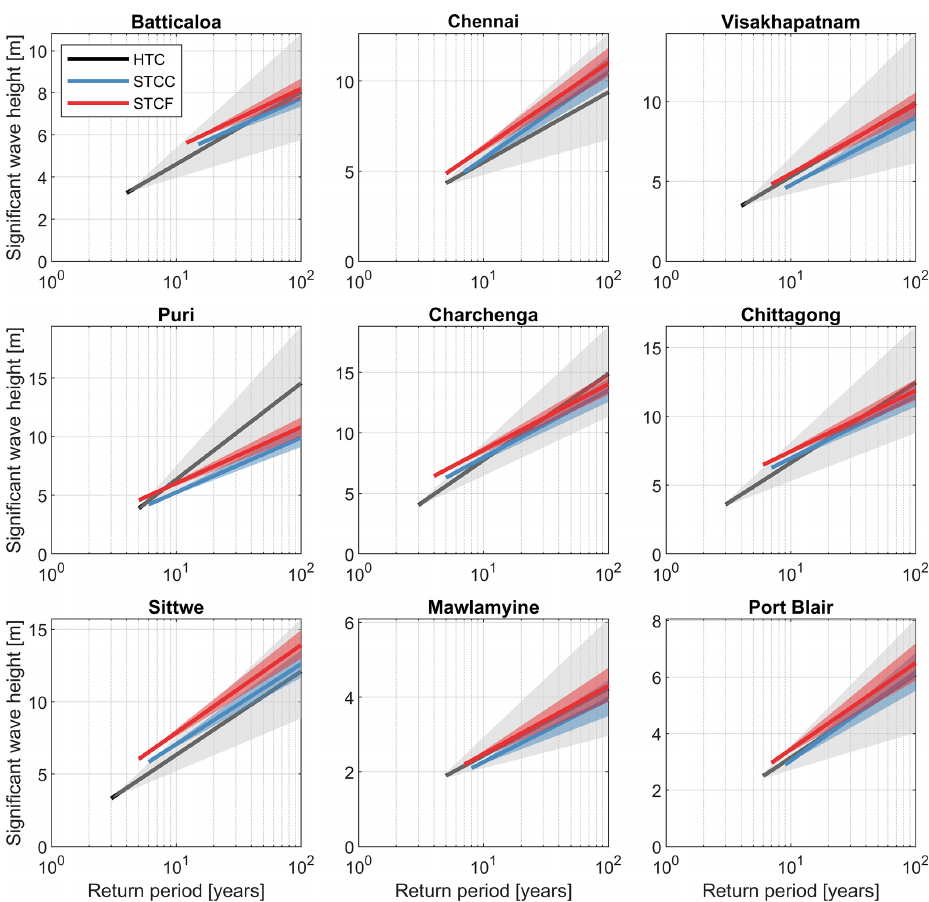
Figure 11. Extreme value analysis for nine different locations for significant wave height based on HTCs (black), STCC (blue) and STCF (red). Per panel both the fit (solid line) and 95% confidence intervals (background fill) are included. The horizontal axis is the return period on a logarithmic scale, and the vertical axis is significant wave height in meters. Note the orientation of locations goes in a clockwise direction through the Bay of Bengal from Batticaloa to Port Blair and the y axis varies per